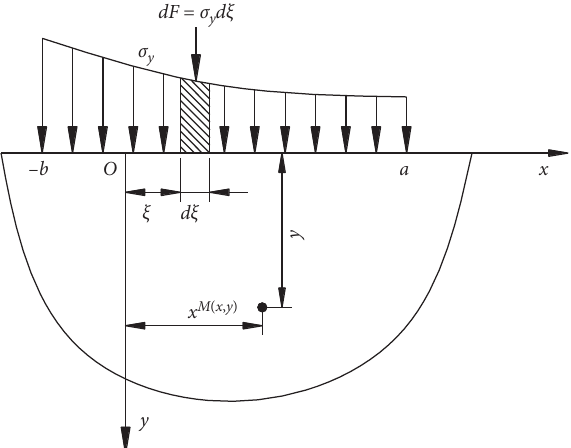
Figure 3: The model of load on the floor after mining the protective